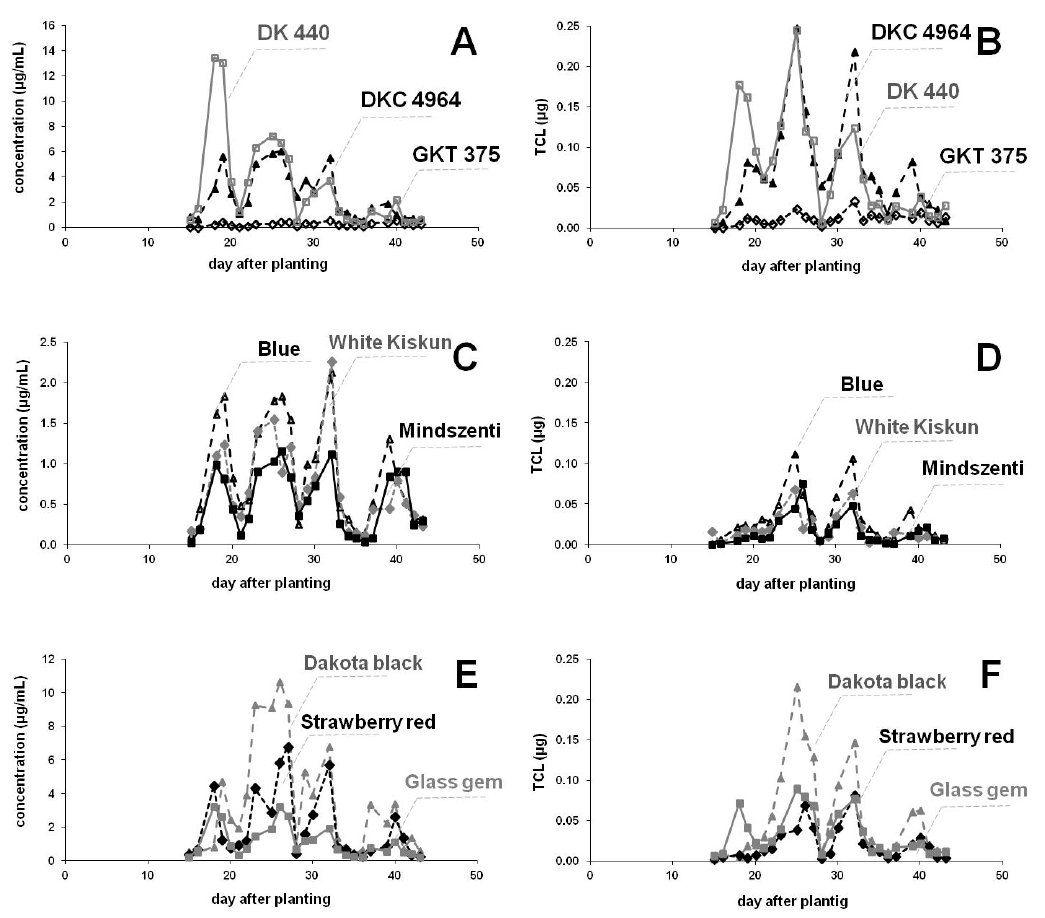
Figure 2. Neonicotinoid (TCL) occurrence from the seed coating in commercial ( A , B ; DK 440 □ , DKC 4964 − Die Sandra ▲ , GKT 372 ◊ ), Hungarian landrace ( C , D ; Blue Δ , White Kiskun ♦ , Mindszenti ■ ) and „heirloom” ( E , F ; Dakota black (cid:78) , Strawberry red (cid:7) , Glass gem (cid:4) ) maize varieties cultivated under semi-field conditions (sown in April). Concentration of TCL ( A , C , E ; µ g / mL) and average amount of TCL ( B , D , F ; µ g) excreted by a single plant in the guttation liquid of maize as a function of time after